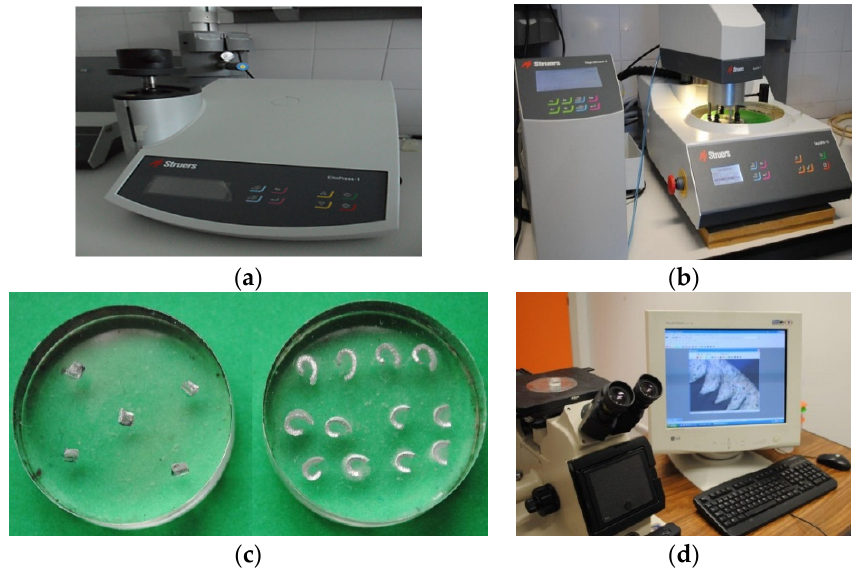
Figure 3. ( a ) Hot mounting press; ( b ) Polishing equipment; ( c ) Chip specimens; ( d ) SOM (Stereoscopic Optical Microscopy) equipment. Optical Microscopy)